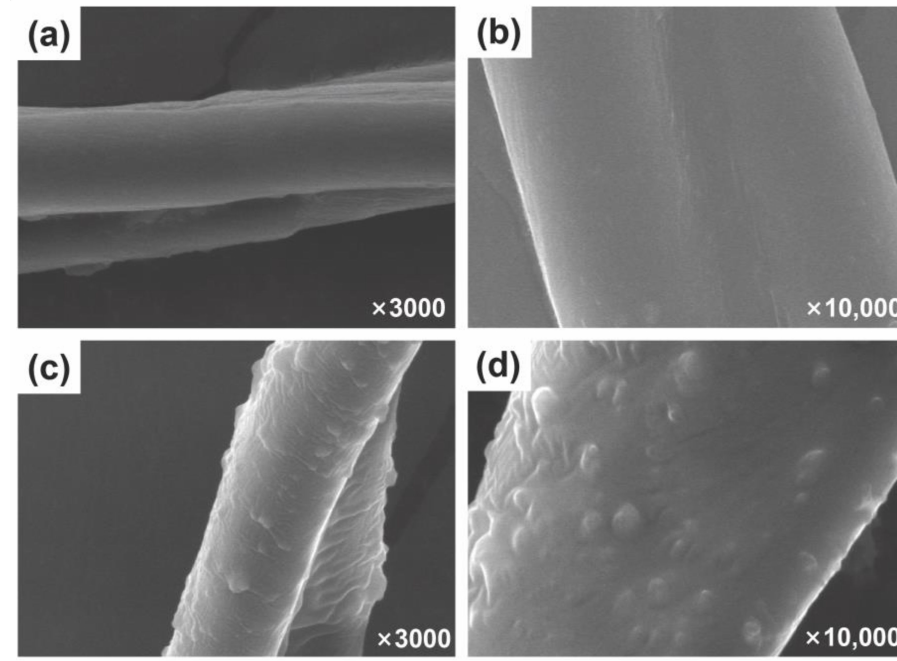
Figure 1. SEM images of unfinished cotton fibers ( a , b ) and finished cotton fibers ( c , d